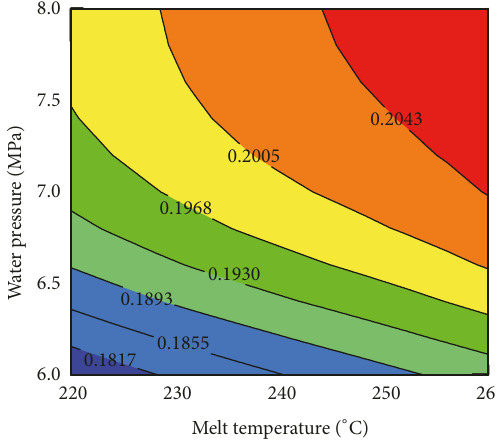
Figure 10: Effect of significant influence parameters on A 22 .